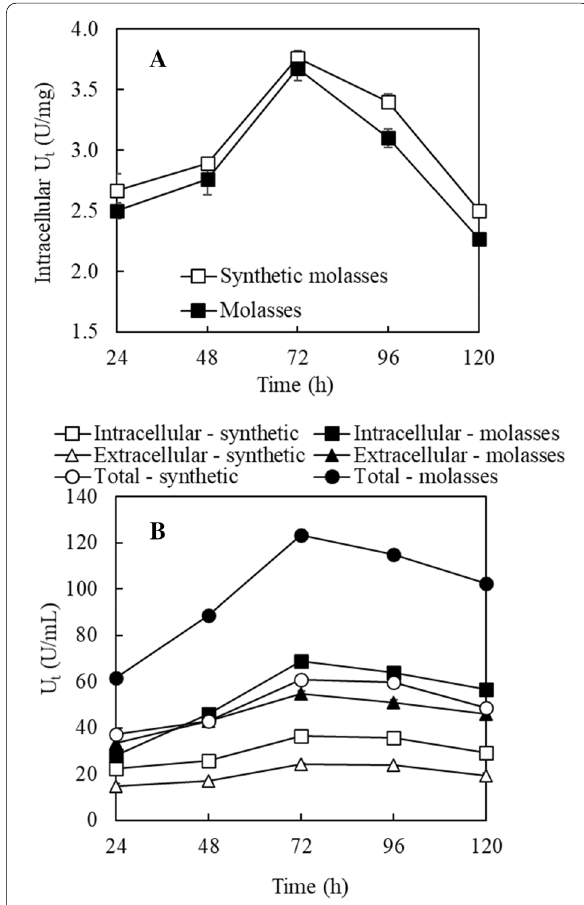
Fig. 2 Transfructosylating activities (U t ) of enzymes produced using molasses and synthetic molasses media by A. pullulans FRR 5284. A Intracellular activities based on cell mass; B intracellular and extracellular activities based on medium